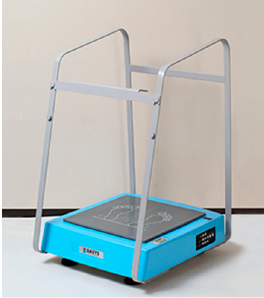
Figure 4. Stabilometer installed with the function of disturbance generation